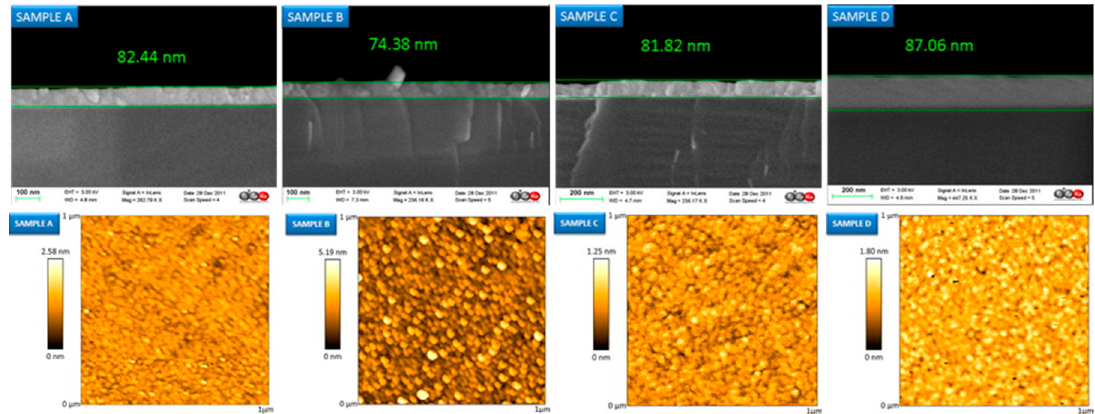
Figure 24. SEM images from the sputtered ITO samples with annealing under vacuum (sample A), nitrogen (sample B), atmosphere (sample C) and no annealing (sample D); on the second row, AFM images for the similar thermal treatments. Reprinted from [111] with permission from Elsevier.